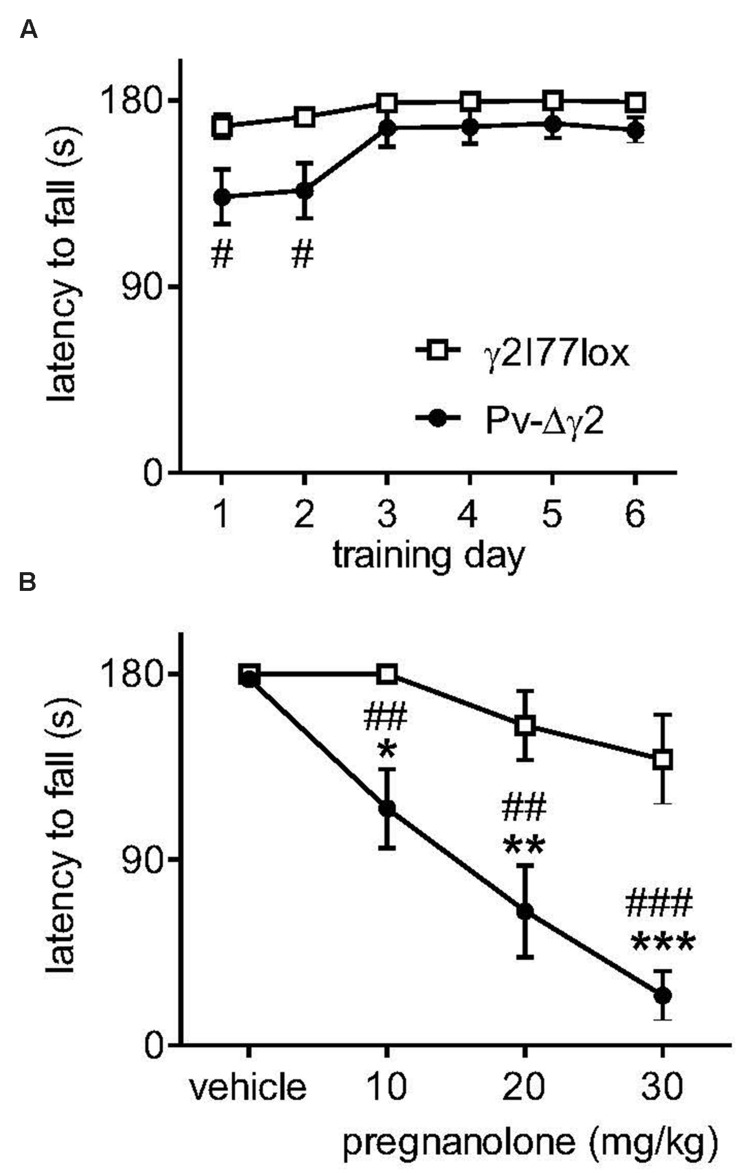
Neurosteroid sensitivity of Pv-Δγ2 mice with targeted inactivation of GABAA receptor γ2 subunit gene in parvalbumin-expressing neurons. (A) Learning the rotarod performance. The rotarod was accelerated from 5 to 20 rpm during 180 s. Data for γ2I77lox control (n = 8) and Pv-Δγ2 (n = 7) mice are presented as daily means of 6 trials ± SEM. #P < 0.05 for the significance of the difference between the mouse lines on training days 1 and 2 (repeated measures ANOVA and Newman–Keuls post hoc tests). (B) Effects of pregnanolone on motor performance. Pregnanolone was administered in cumulative doses (10+10+10 mg/kg i.p., total 30 mg/kg) to the same animals and the performance tested as in panel (A). One-way ANOVA and Newman–Keuls post hoc tests: ##P < 0.01, ###P < 0.001 for the significance of the difference between the mouse lines, ∗P < 0.05, ∗∗P < 0.01, ∗∗∗P < 0.001 for the significance of the difference from vehicle injection within the Pv-Δγ2 line. Data are presented as means ± SEM.